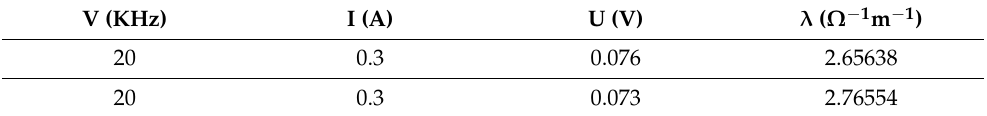
Table 5. Electrical conductivity of CaCl 2 at 1000 ◦